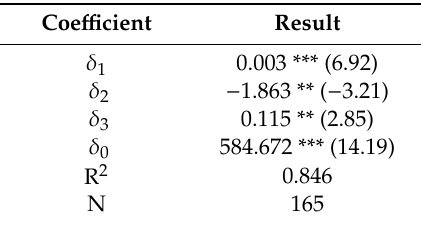
Table 3. Regression results of Equation (4).